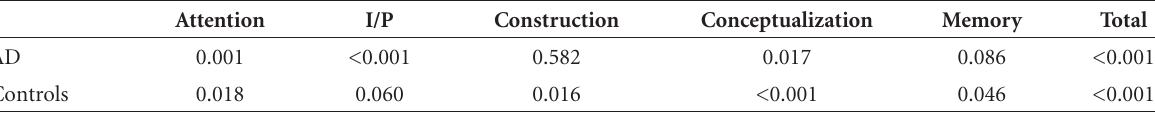
Table 1. Intragroups